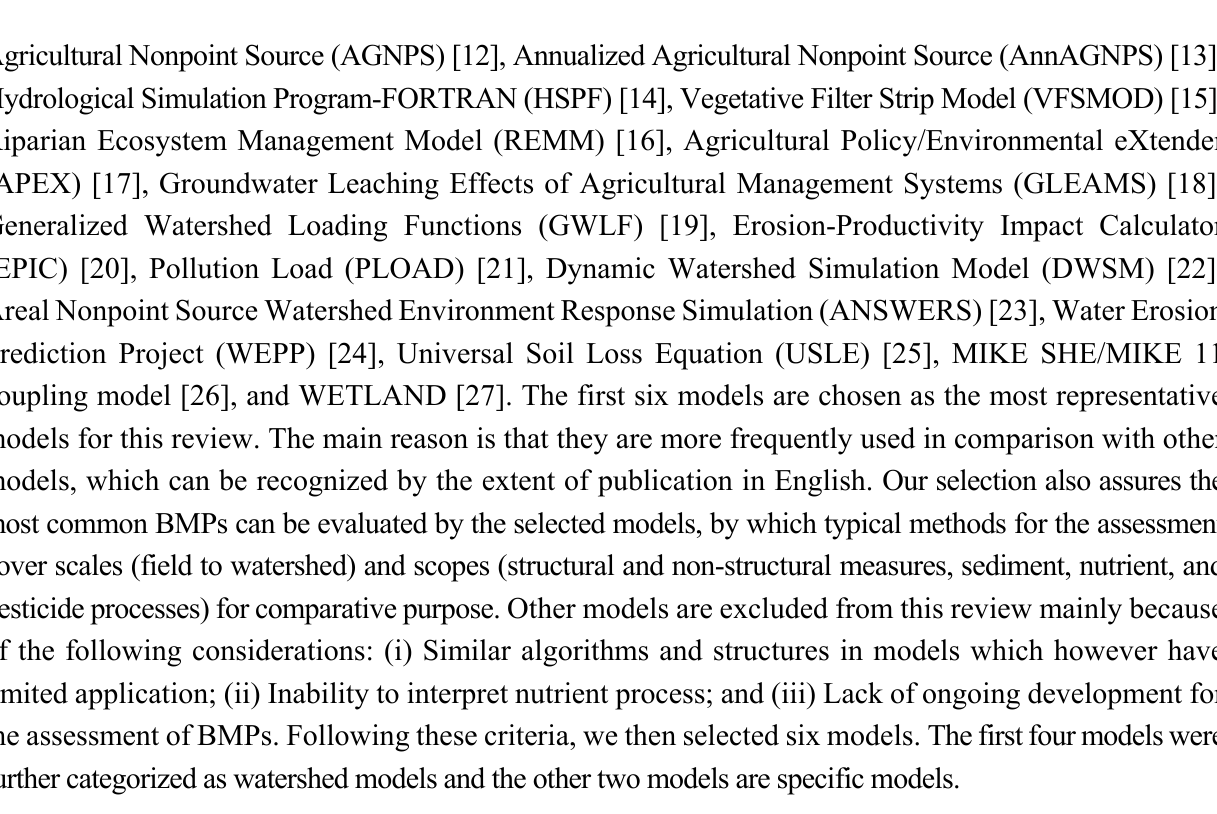
Table 1. The summary of the studies on agricultural BMPs’ assessment using watershed models. BMP Study Area Model